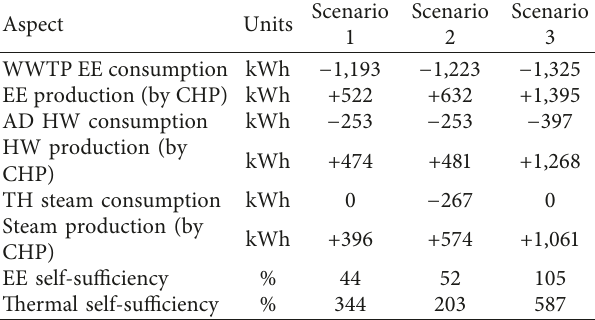
Table 3: Daily plant-wide energy balance of WWTP using AD and codigestion of sewage